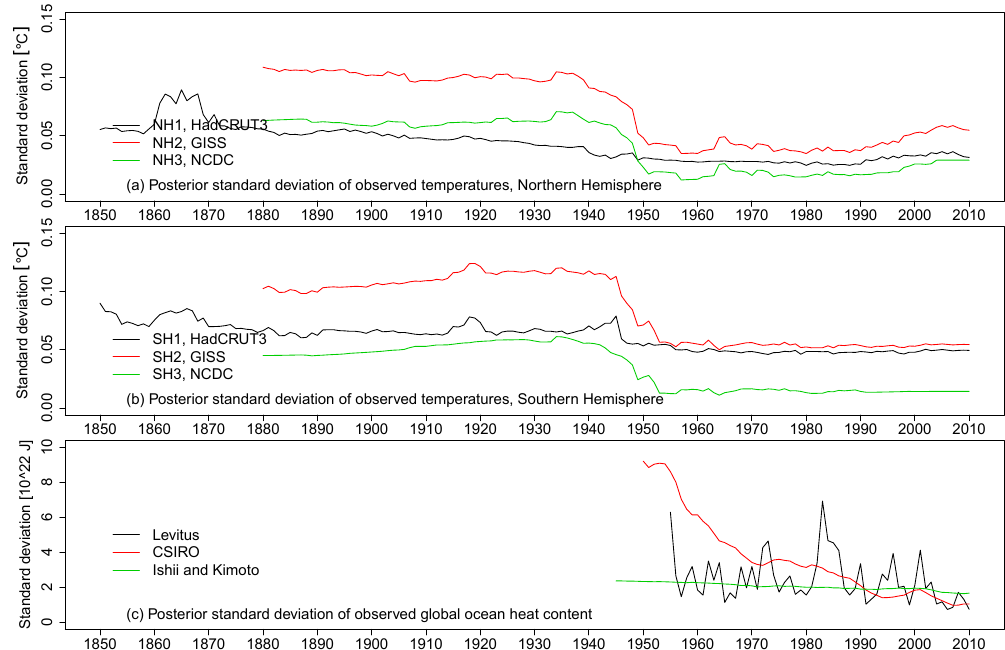
Fig. B4. Posterior estimates of standard deviations of the annual temperature and ocean heat content data.